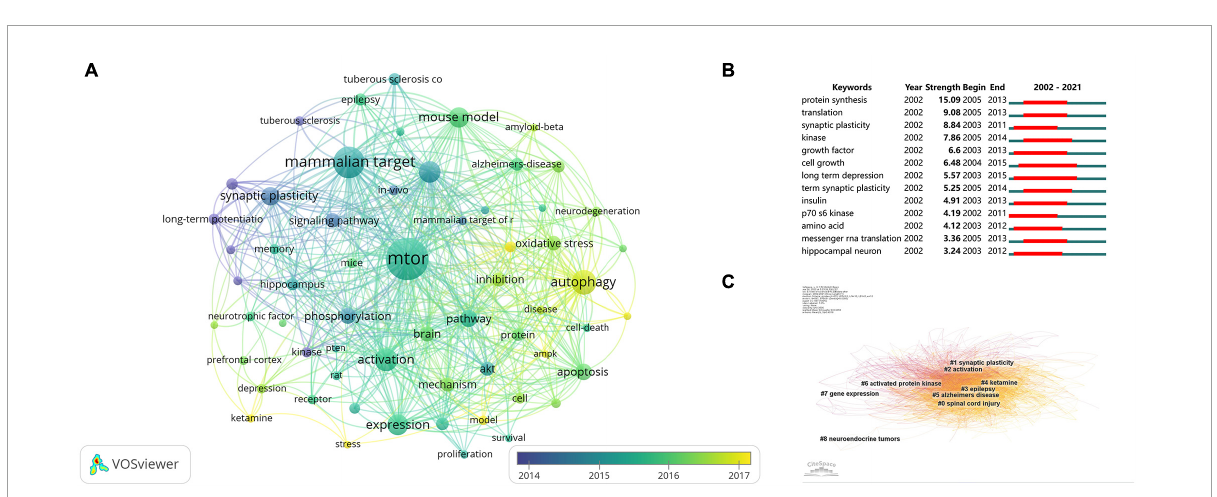
FIGURE6 Keywords linked to mammalian target of rapamycin (mTOR) in neuroscience studies. (A) The co-occurrence analysis of keywords using VOSviewer. (B) Top 13 keywords with the strongest citation bursts on CiteSpace (strong citation bursts indicate that a variable has changed dramatically in a short time; the red bar indicates the duration of the outbreak). (C) The clustering analysis of an mTOR co-citation network with keywords based on